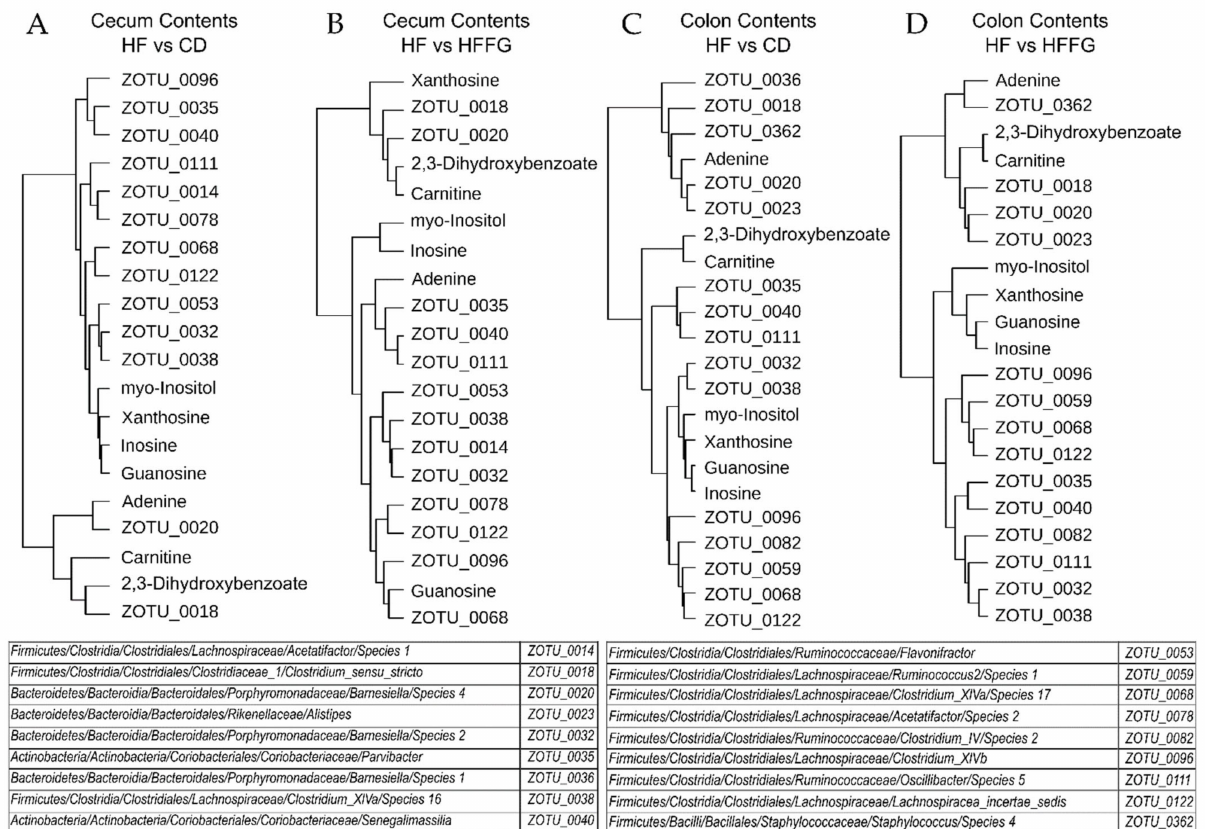
Figure 7. Dendrogram cluster analysis using Pearson distance measure for HF-altered and FG- corrected OTUs and metabolites significantly contributing to separation between groups in the large intestines. Dendrograms are show for ( A ) HF versus CD comparisons in the cecum contents, ( B ) HF versus HFFG comparisons in the cecum contents, ( C ) HF versus CD comparison in the colon contents, and ( D ) HF versus HFFG comparison in the colon